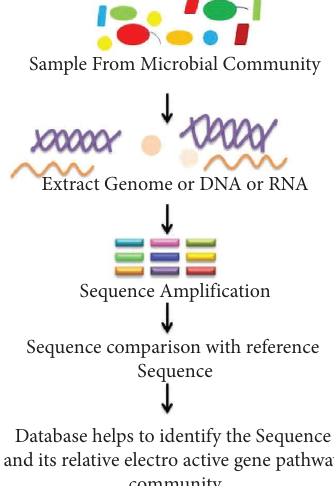
Figure 2: Bioinformatics approaches help to identify electroactive